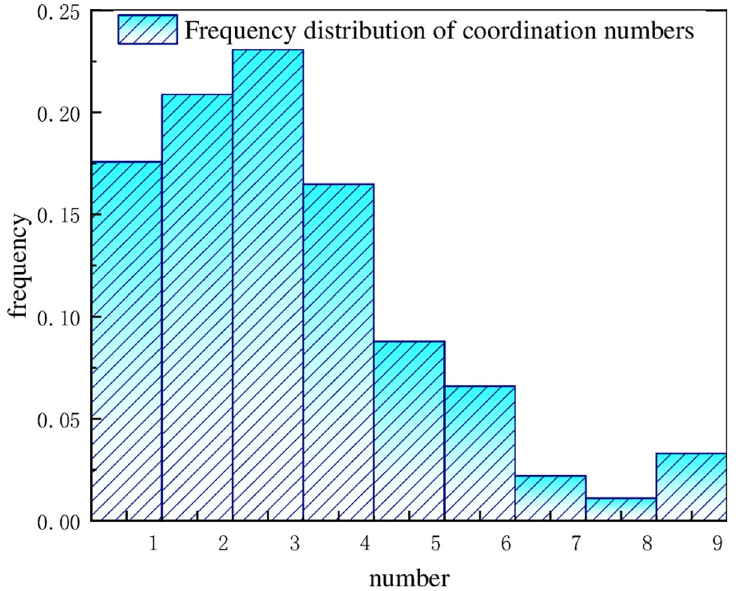
Fig 9. Histogram of distribution frequency of the coordination